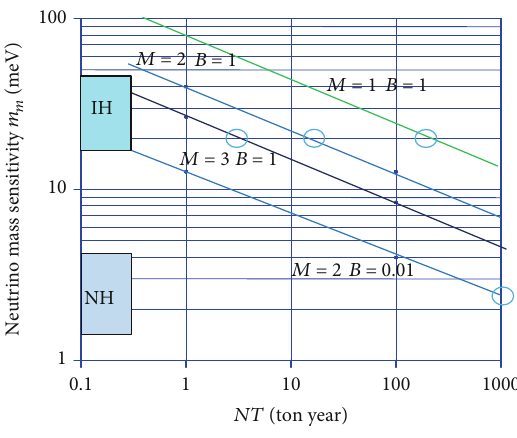
Figure 2: Neutrino mass sensitivities m exposure NT . M and B are the NME and the BG rate per t y. d 0 = 1 : 4 , ε = 0 : 55 , and η = 0 : 9 (see equation (5)).